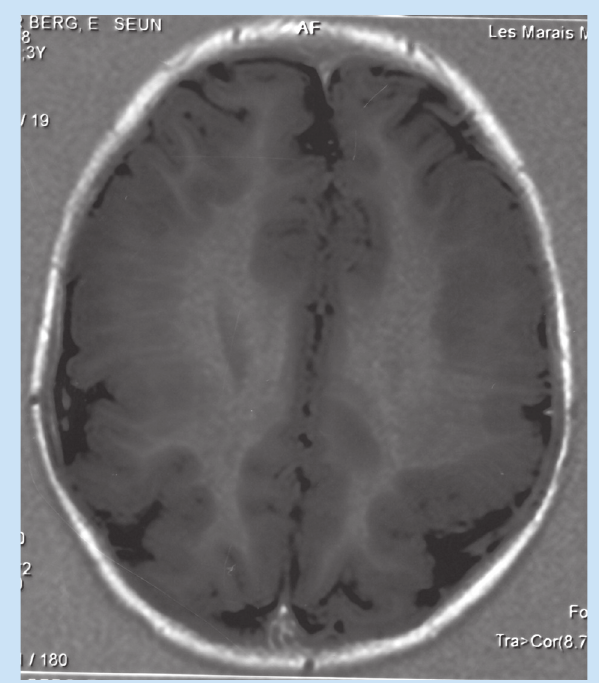
Fig.3. Axial T1-weighted image with inversion recovery sequence. Some cortical loss with irregular cortex, noted in the posterior aspect of the sylvian fissure extending onto the parietal